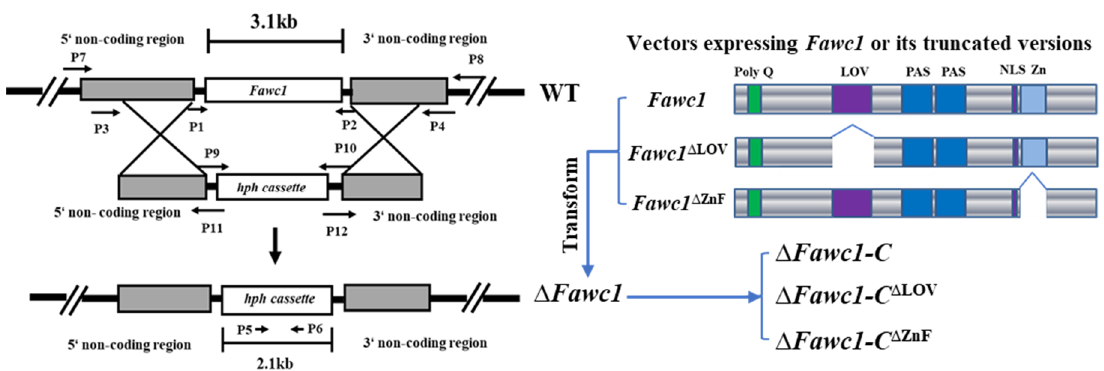
Figure 2. Generation of the transgenic mutants of F. asiaticum. Schematic diagrams of homologous recombination occurred between the replacement vector carrying the hygromycin resistance marker ( hph ) and the target gene ( Fawc1 ) of F. asiaticum strain EXAP-08, resulting in the knockout mutant ( ∆ Fawc1 ). Meanwhile, the wild-type Fawc1 or its truncated versions, Fawc1 ∆ LOV and Fawc1 ∆ Zn , were amplified from genomic DNA of EXAP-08 and cloned into the flu6 plasmid, and then transformed into the ∆ Fawc1 mutant, resulting in the complementation strain ∆ Fawc1 - C , and ∆ Fawc1-C ∆ LOV and ∆ Fawc1-C ∆ ZnF mutant strains. The knockout mutant ∆ Fawc2 and its complementation strain ∆ Fawc1 - C were generated via a similar strategy.